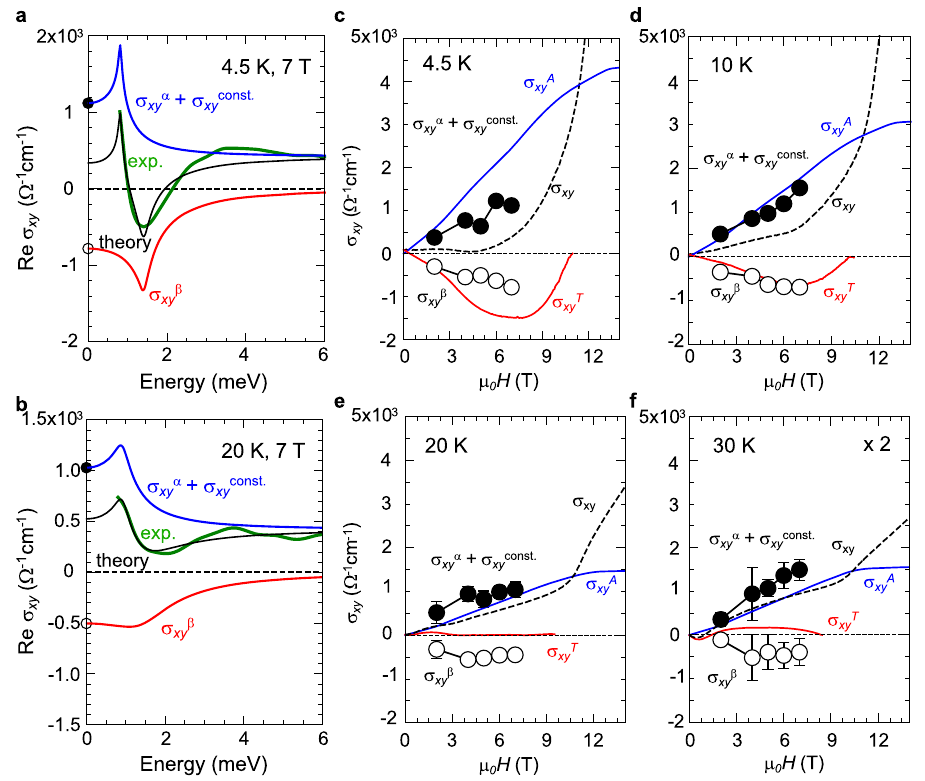
Fig. 4 Anomalous Hall effect (AHE) and topological Hall effect (THE) obtained from terahertz and transport measurements. a , b The decomposition of the experimental spectra into two resonances corresponding to the AHE (blue) and THE (red) at ( a ) 4.5 K and ( b ) 20 K. The experimental and theoretical spectra are shown by green and black curves, respectively. These spectra for 4.5 K are multiplied by a factor of two. c – f The magnetic- fi eld dependence of the AHE (Re{ σ xy α + σ xy const. }, fi lled circle) and THE (Re{ σ xy β }, open circle) at ω = 0 obtained from the analysis for terahertz spectra; ( c) 4.5 K, ( d) 10 K, ( e) 20 K, and ( f) 30 K. The zero-frequency limit ( ω = 0) of the AHE ( σ xy α + σ xy const. ) and THE ( σ xy β ) are displayed by fi lled and open circles also in a , respectively. The red and blue curves in c – f show the AH conductivity σ xy A and TH conductivity σ xy T deduced from the transport measurement, respectively. The total Hall conductivity is also shown by dotted curves. The decomposition of AHE and THE is possible in a relatively low fi eld region ( ≤ 7 T) as exempli fi ed in early works 21,33,36 , whereas the steep increase of σ xy at low temperatures and above 12 T in a fi eld-aligned ferromagnetic region is supposed to stem from the spin-chirality skew scattering 38 – 40 (see also Supplementary Note